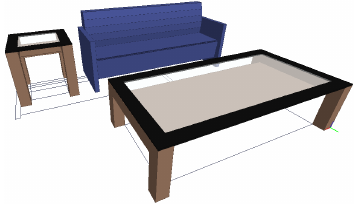
Figure 3: Example of living room